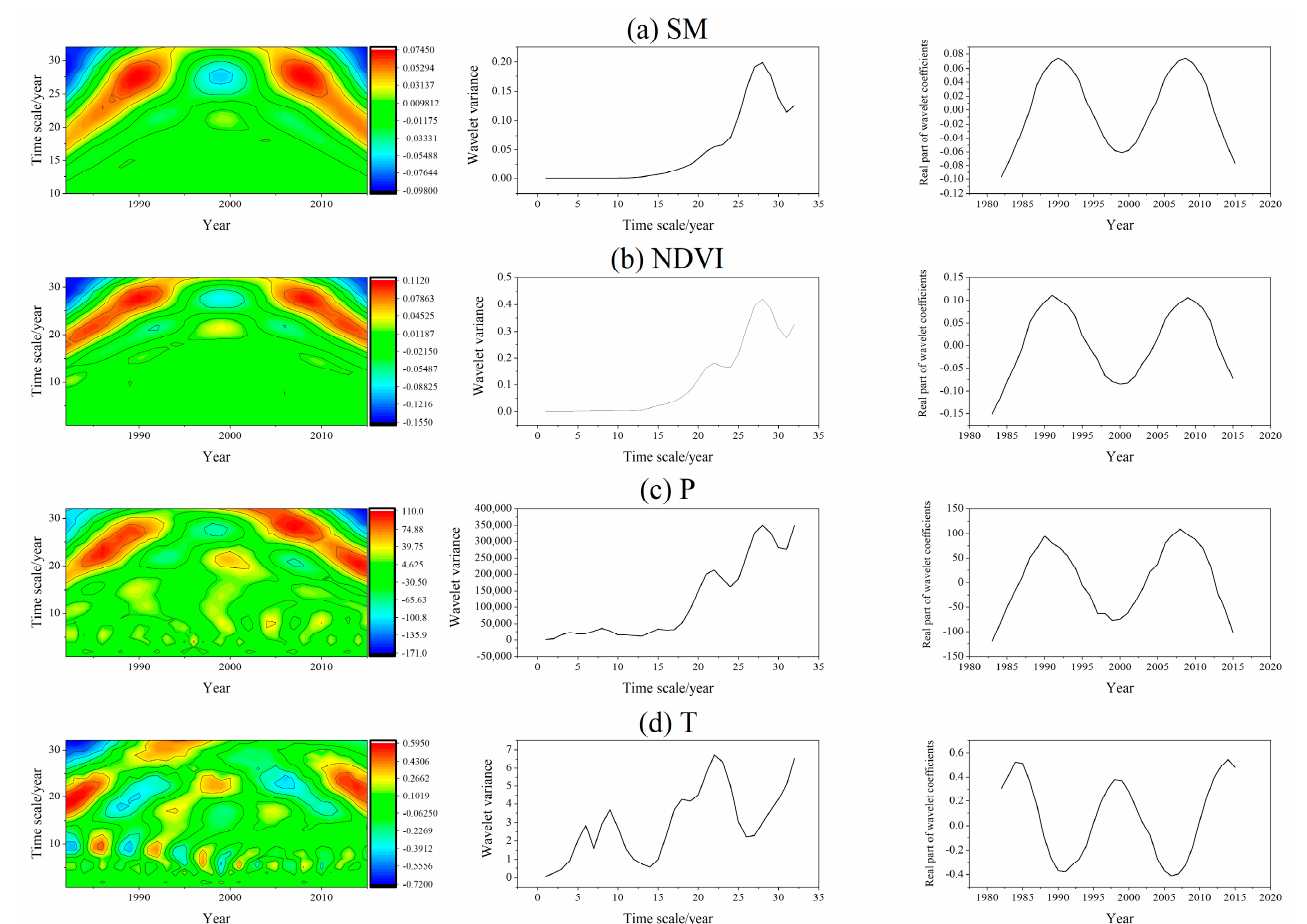
Figure 6. Wavelet analysis results of SM, NDVI, precipitation (P), and temperature (T) on the Tibetan Plateau from 1982 to 2015: the wavelet coefficient contour plot is on the left, the wavelet variance plot is in the middle, and the right panel indicates the process of wavelet coefficient variation in the real part.